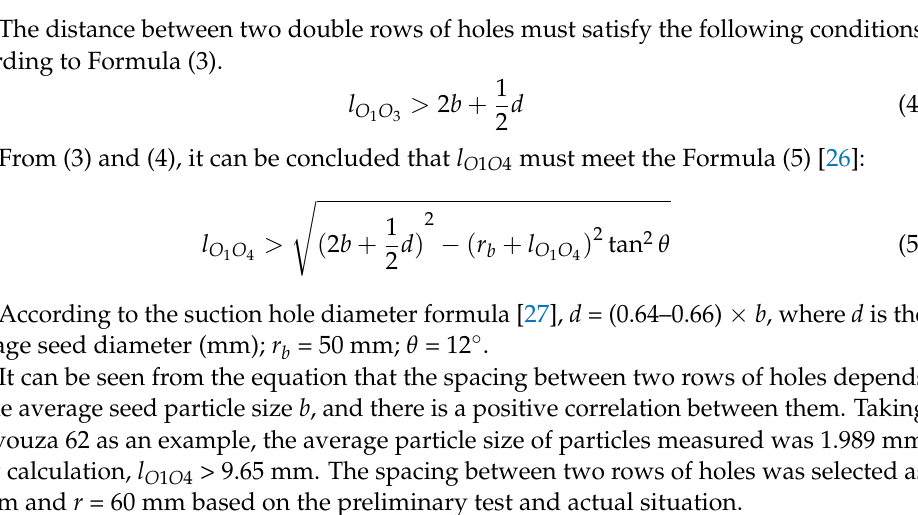
Figure 4. A schematic diagram of the suction hole arrangement.